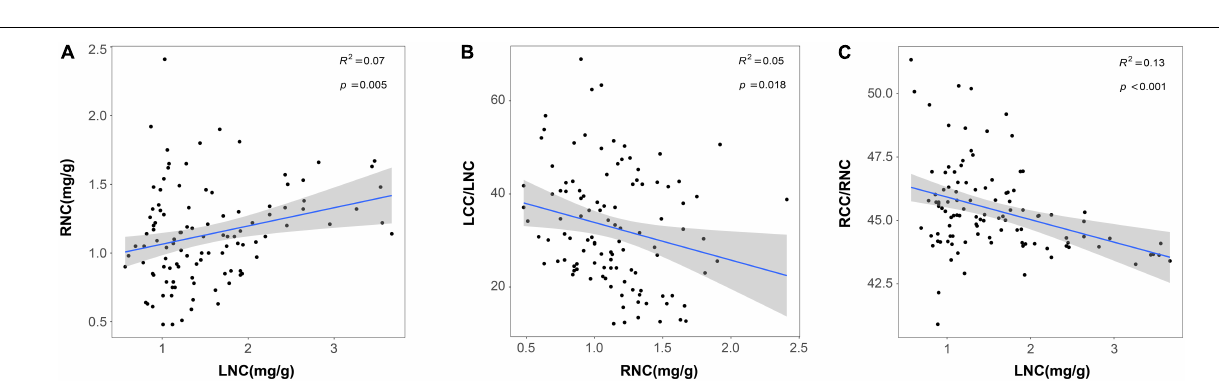
FIGURE 3 | Relationships between LNC and RNC (A) ; RNC and LCC/LNC (B) and LNC and RCC/RNC (C) . Trait acronyms: LNC = leaf nitrogen content, LCC/LNC = the ratio between leaf carbon and nitrogen, RNC = root nitrogen concentration, RCC/RNC = the ratio between root carbon and nitrogen. The R 2 (coefficient of determination) and p -values are obtained from the linear regression analyses. Shaded areas show 95% confidence interval of the fit